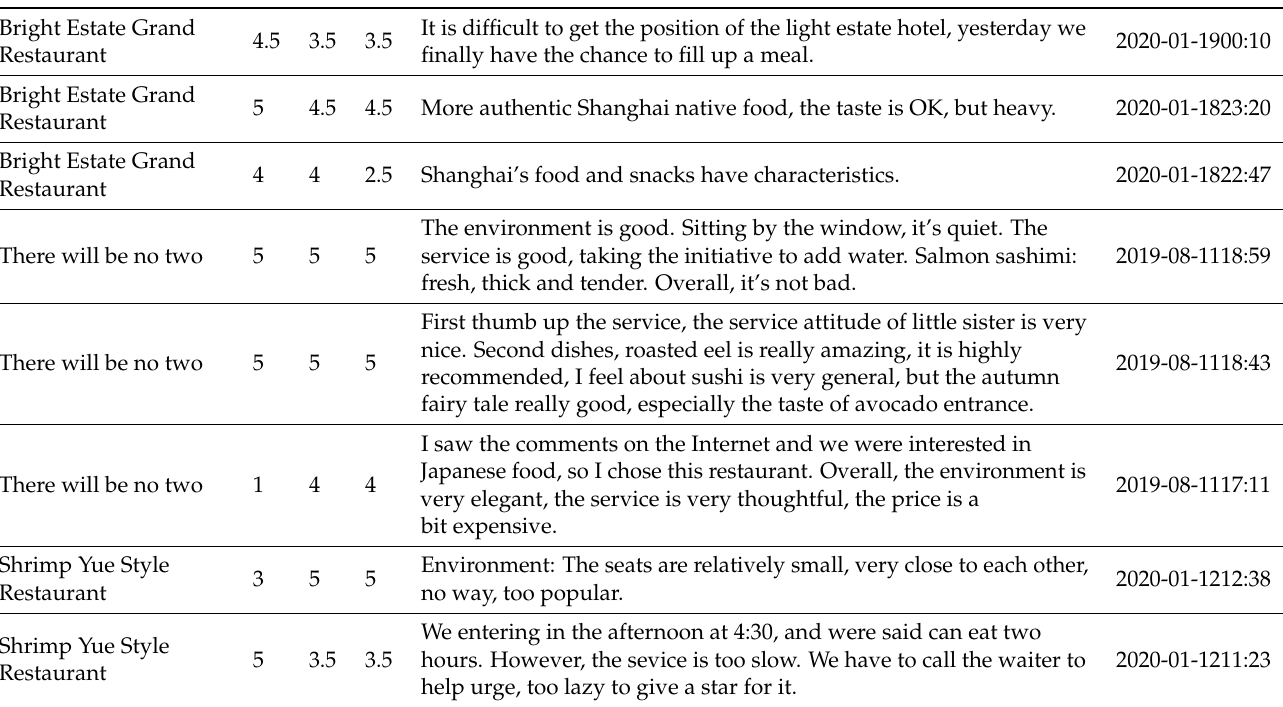
Table 1. Pre COVID-19 data.